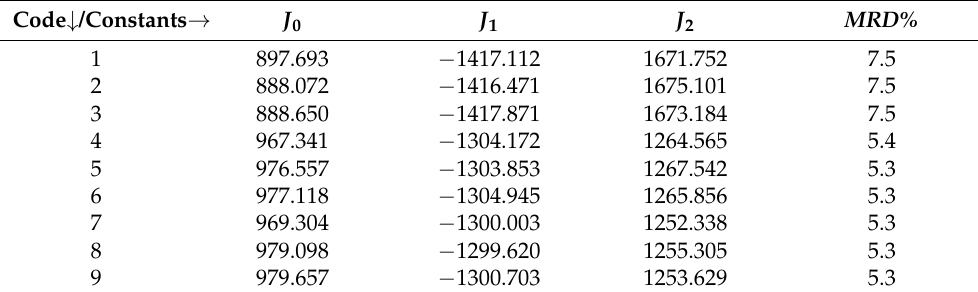
Figure 1. Overall MRD% and their standard deviations (SDs) using Equation (1) for investigated data sets. Table 2. Model constants for the solubility data of sulfadiazine in acetonitrile + methanol mixtures expressed in different concentration units and the obtained mean relative